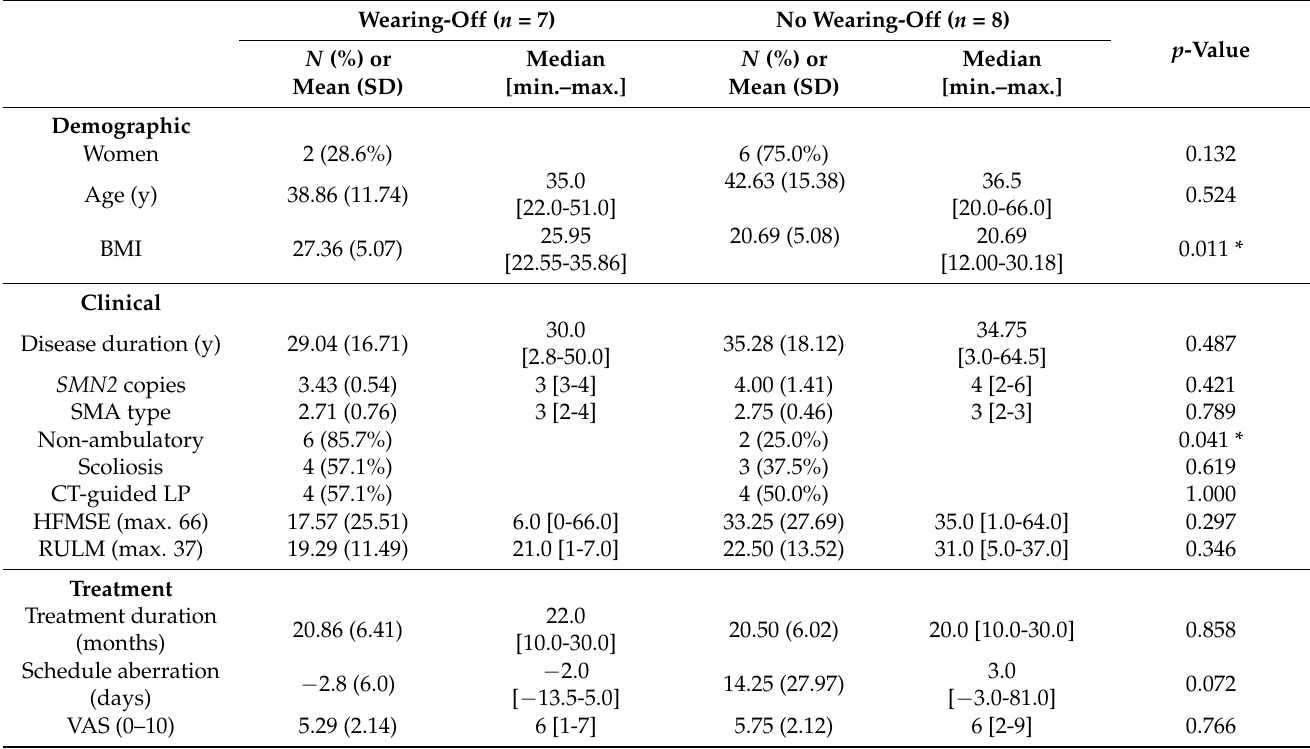
Table 2. Characteristics of SMA patients repeatedly reporting wearing-off vs. no perceived wearing-off phenomena.